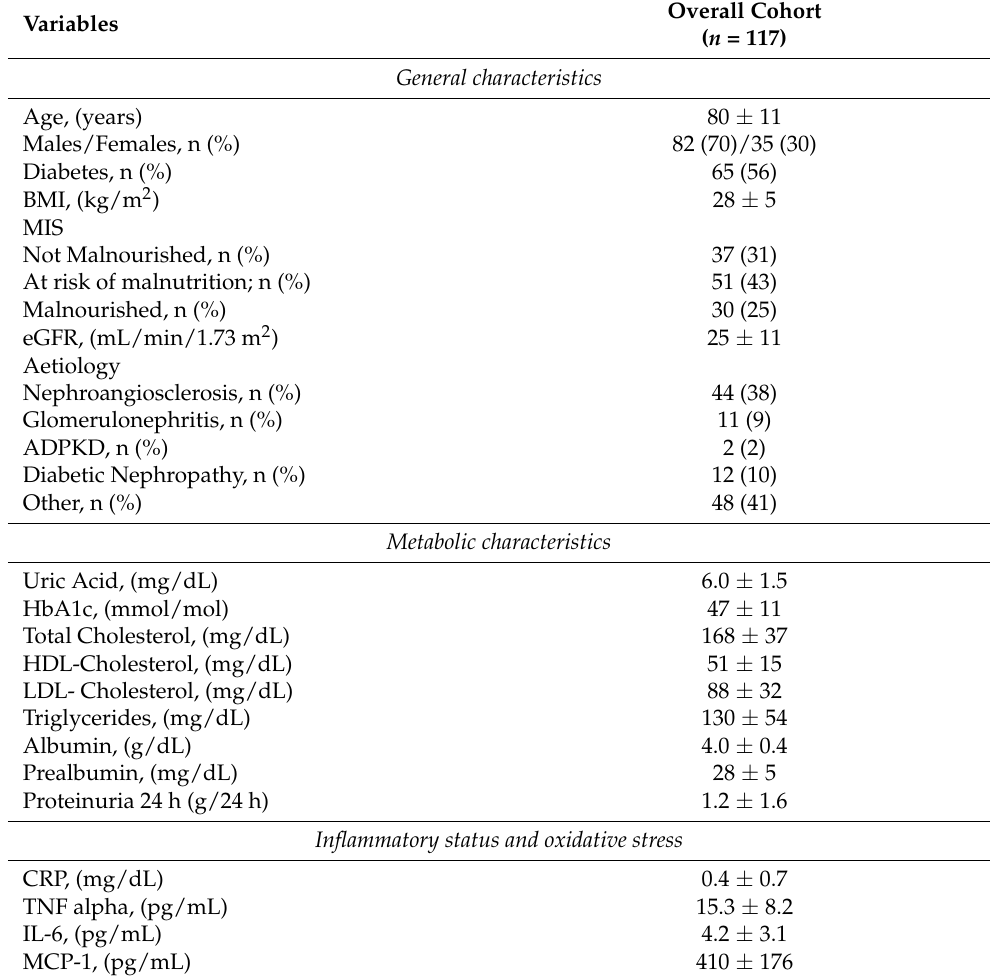
Table 1. General cohort